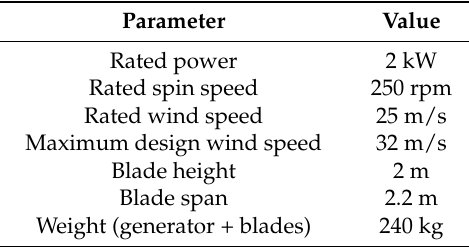
Figure 4. The H-type vertical axis wind turbine (VAWT): ( a ) modeling of the vibration system; ( b ) the VAWT and the details of its supports (including schematics; unit: mm). Table 3. Details of the wind